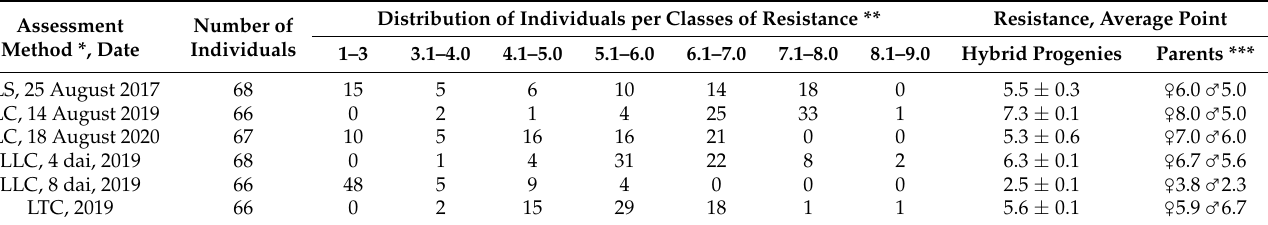
Table 1. Distribution of ‘Sudarynya’ × 13/11-09 F1 progeny individuals per classes of leaf and tuber LB resistance assessed by different methods.